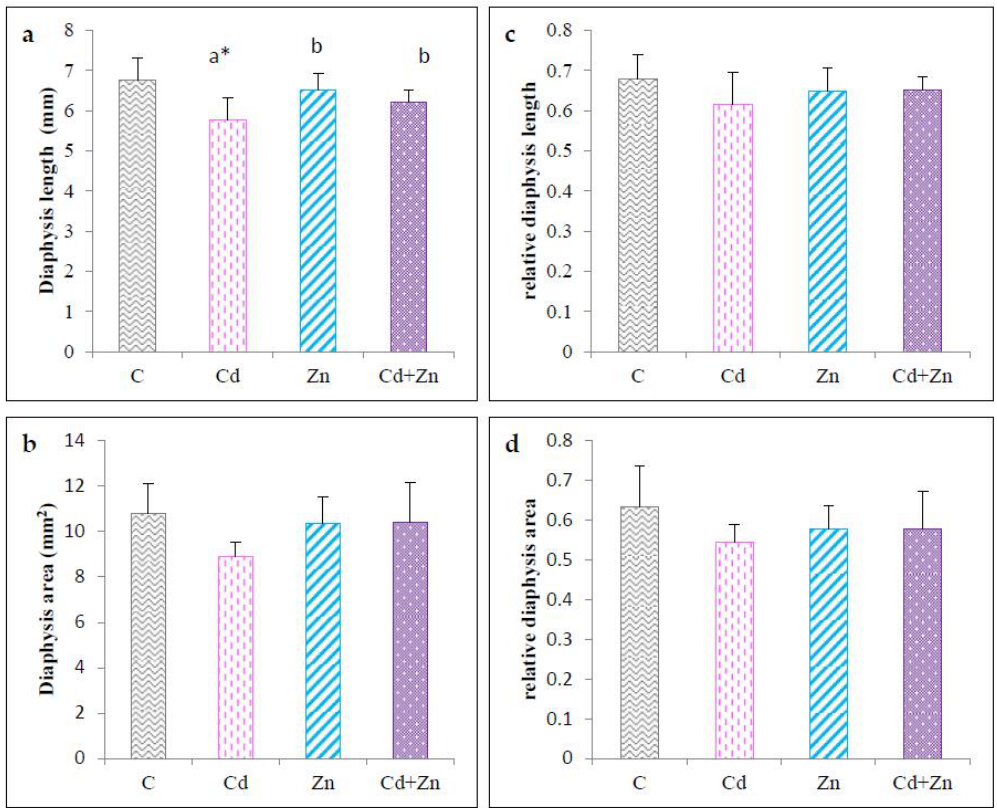
Figure 5. Length diaphysis ( a ), diaphysis area ( b ) relative length diaphysis ( c ) and relative diaphysis area ( d ) of femur of rat pups (PND21) from control females and pups from females exposed to cadmium (50 mg/L Cd as CdCl2) and / or zinc (60 mg/L Zn as ZnCl2) during gestation and lactation. Means ± SEM from six samples in each groups; a* ( p < 0.01); a ( p < 0.05): significant difference compared to the control group (C); b ( p < 0.05): significant difference compared to the Cd group (Cd).